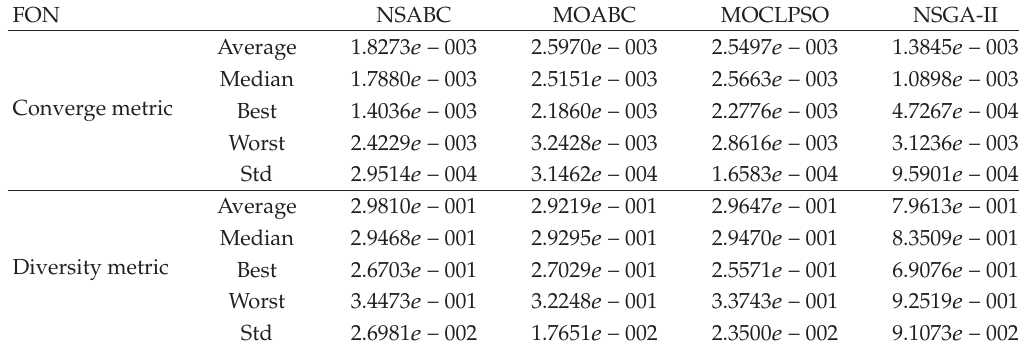
Table 3: Comparison of performance on FON after 10000 FEs.